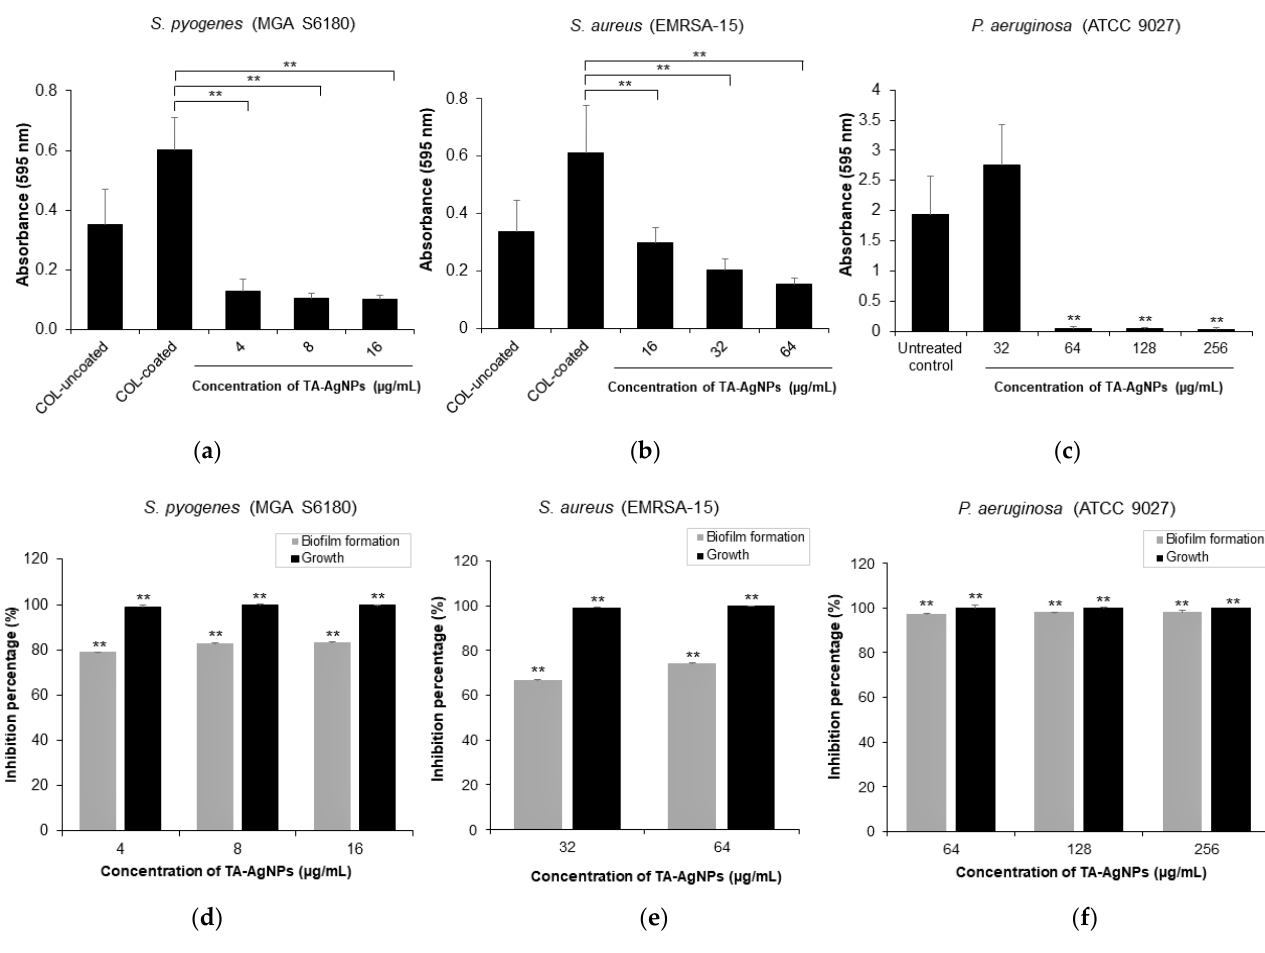
Table 3. MBEC of TA-AgNPs against three wound bacteria.